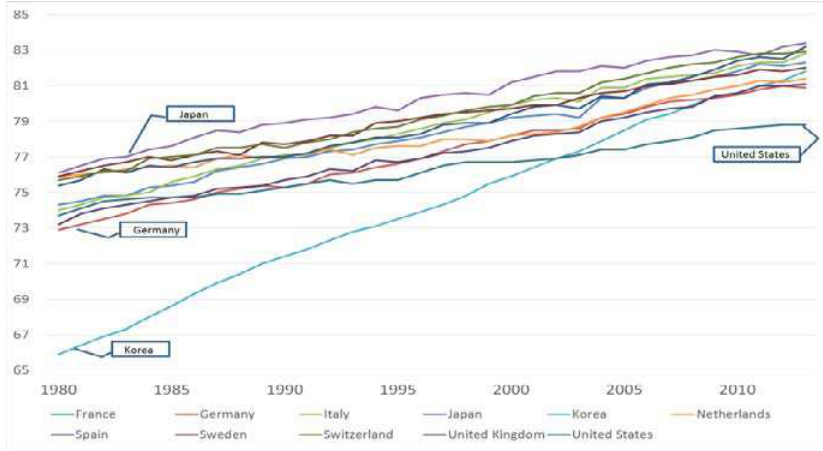
Fig. 1. Life expectancy at